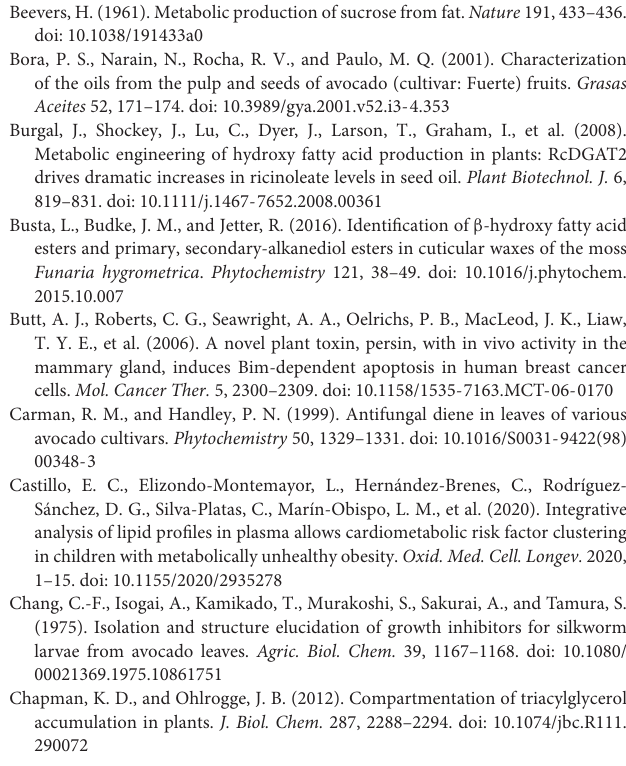
Supplementary Figure 1 | Examples of plant tissues used for acetogenin and fatty acid analyses. Supplementary Figure 2 | Potential sites of O-methylation of AcO-Avocadene methyl ether. Supplementary Figure 3 | Avocado seed imbibition. Supplementary Figure 4 | Correlation networks from avocado individual tissue samples. Supplementary Table 1 | Acetogenin